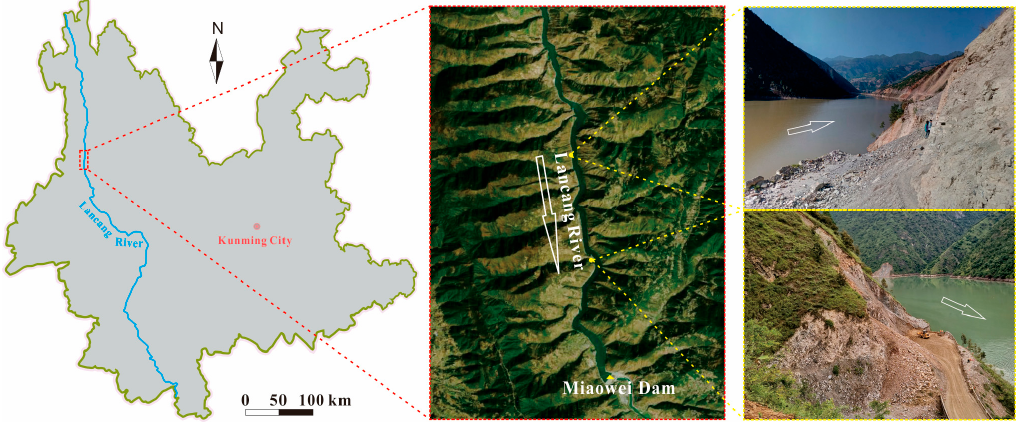
Figure 1. Location of Miaowei reservoir area in Yunnan province and two landslide sites.